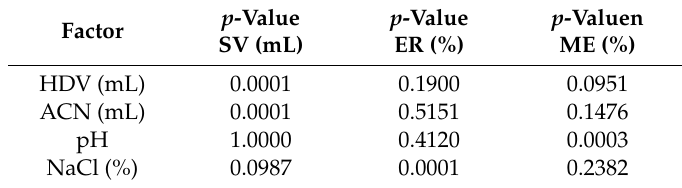
Table 1. Analysis of variance (ANOVA) on each factor a ff ecting dependent variable of interest. p -Value Factor SV